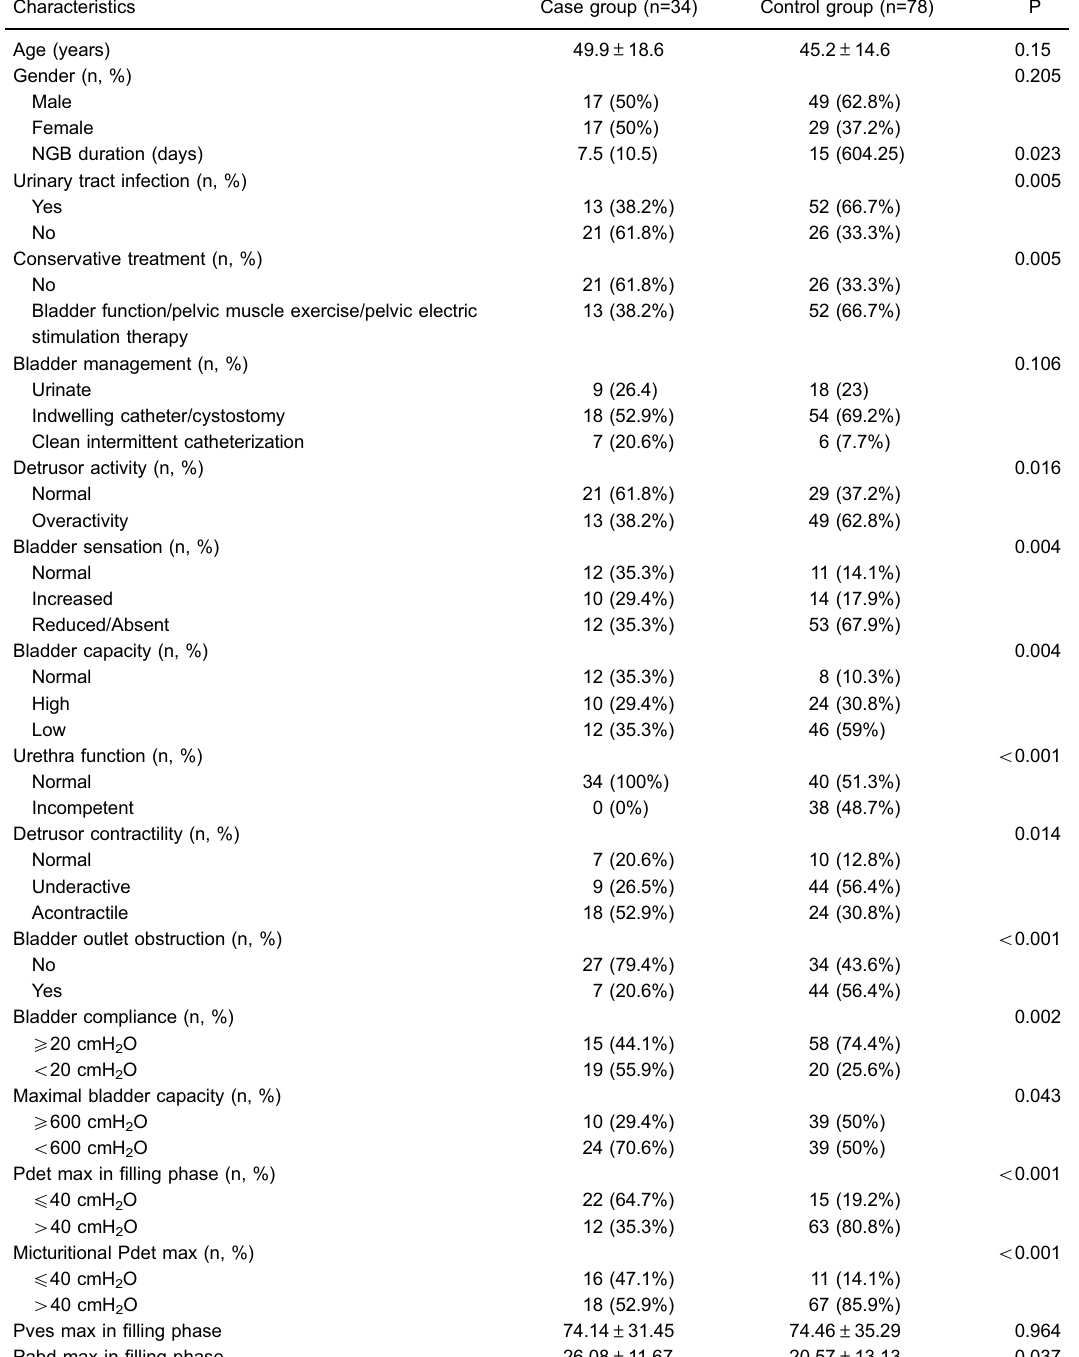
Table 1. Baseline characteristics of neurogenic bladder patients (NGB) with upper urinary tract damage (case group) or without it (control group).